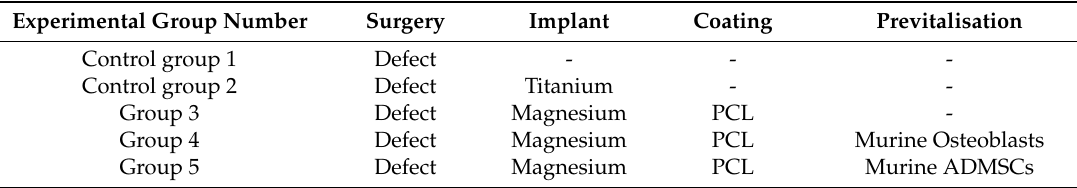
Table 1. Experimental animal